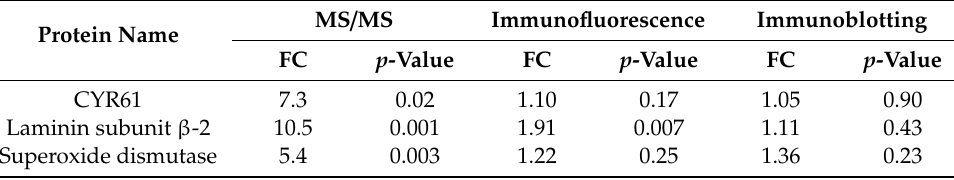
Table 3. The table shows average fold change (FC) in protein levels upon incubation of primary human fetal retinal pigment epithelial cells (RPE) in Dulbecco’s Modified Eagle’s Medium (DMEM) with 1% sericin for seven days in comparison to control (cultured in DMEM alone). FC was calculated as follows: FC = ((mean of protein expressions in RPE cultured in DMEM with 1% sericin) / (mean of protein expressions in RPE cultured in DMEM without sericin)). Data are averages from triplicates. CYR61 = Cysteine-rich angiogenic inducer 61 protein.